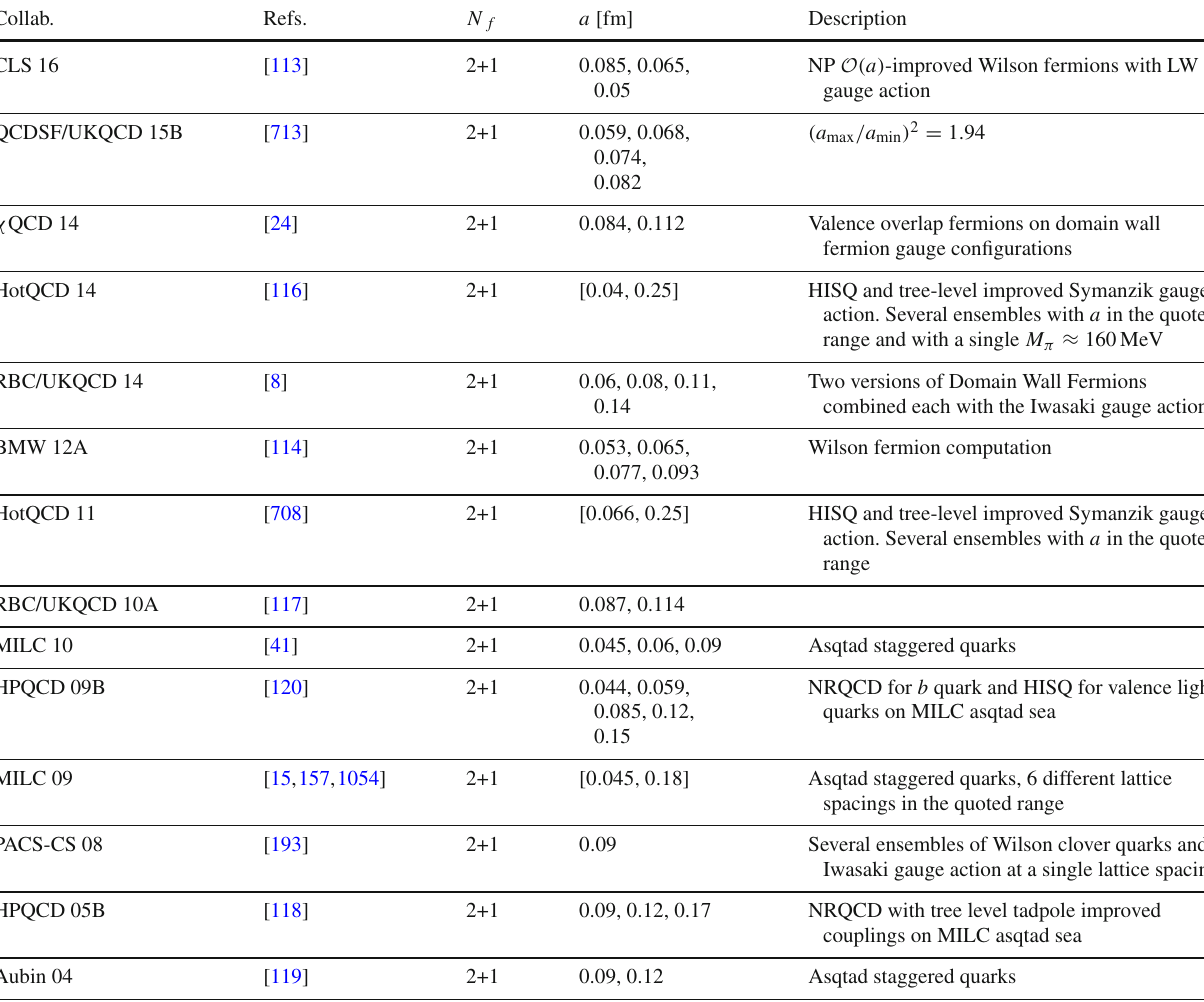
Table 198 Continuum extrapolations/estimation of lattice artifacts in scale determinations with N f = 2 + 1 quark flavours